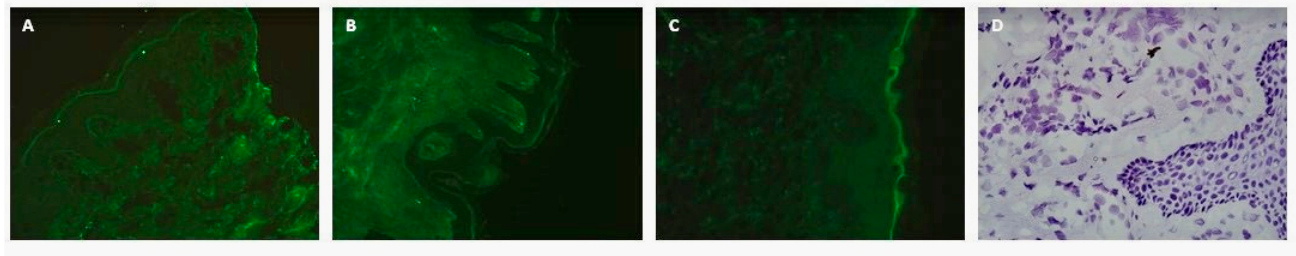
Figure 1. The representative photos of negative controls: without the primary ( A ), secondary ( B ), both types of antibodies ( C ), and staining with hematoxylin ( D ). Magnification: 500×.